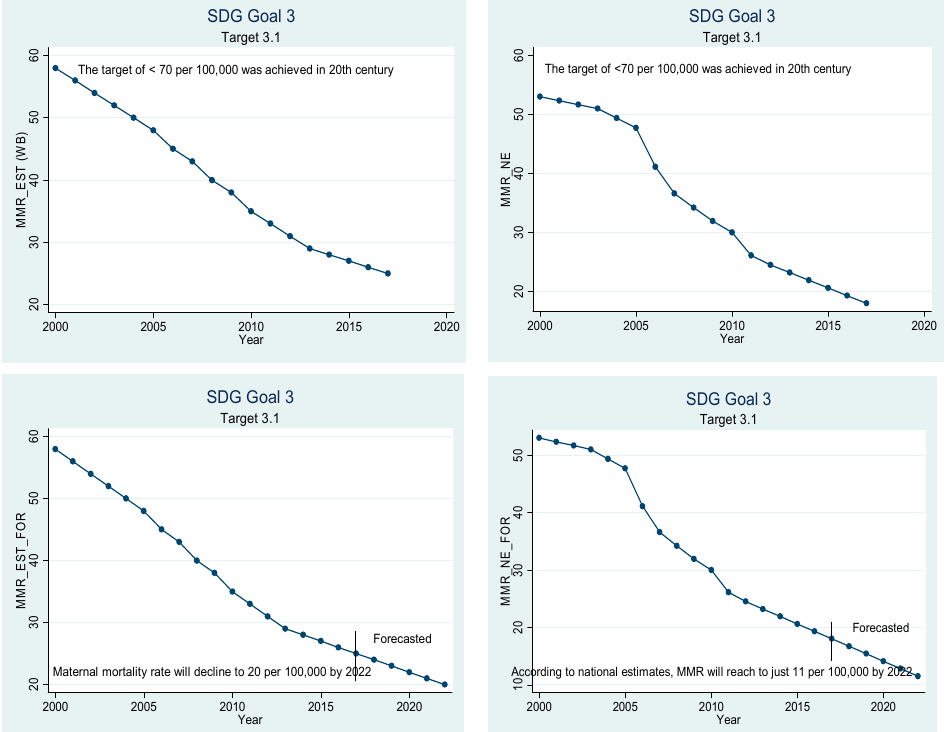
Int. J. Environ. Res. Public Health 2021 , 18 , x